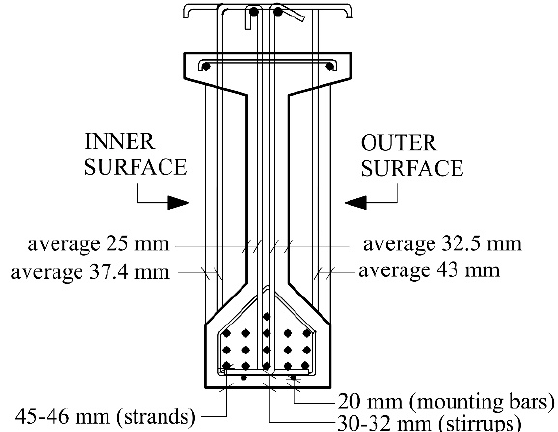
Figure 6. Concrete cover thickness measured in Girder 2.